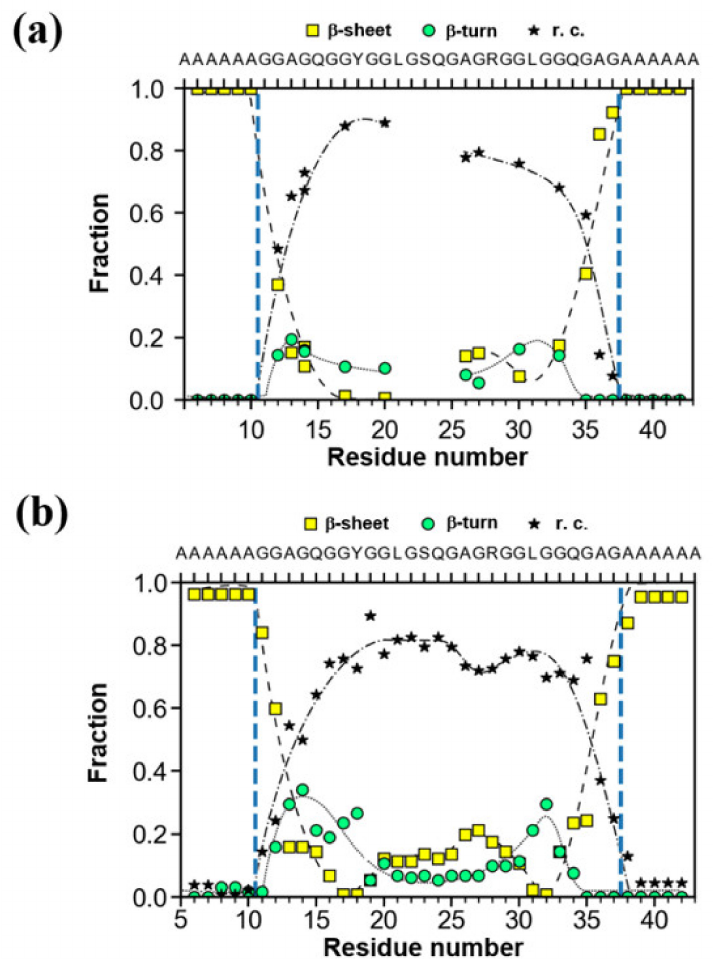
Figure 6. ( a ) The fractions of several conformations, i.e., AP- β sheet, random coil and β -turn determined using 13 C CP / MAS NMR for the 13 C-labeled individual residues in 47-mer peptide, (E) 6 (A) 6 GGAGQGGYGGLGSQGAGRGGLGGQGAG(A) 6 (E) 6 (Table 1 (I)) as the sequential model of the Gly-rich region (Figure 3a). The broken, dash-dotted and solid lines indicate change in the fractions of AP- β sheet, random coil and β -turn conformations, respectively as a function of residue number. ( b ) The fractions of several conformations calculated by the structural identification (STRIDE) algorithm, for the representative structure of the replica exchange molecular dynamics (REMD) simulations with the lowest temperature replica for the individual residues in the sequence, (A) 6 GGAGQGGYGGLGSQGAGRGGLGGQGAG(A) 6 shown for a comparison [62]. The arrangement of the peptide chains with the sequences before MD simulation was as follows. The four extended peptide chains were oriented in antiparallel forms within the planes and parallel between the planes. Three parallel planes were assumed. The intermolecular hydrogen bonding systems of the (A) 6 blocks were set in a staggered packing